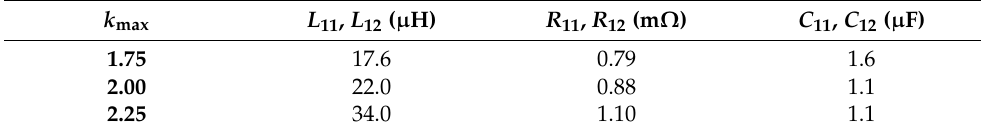
Table 3. Parameters of inductors and